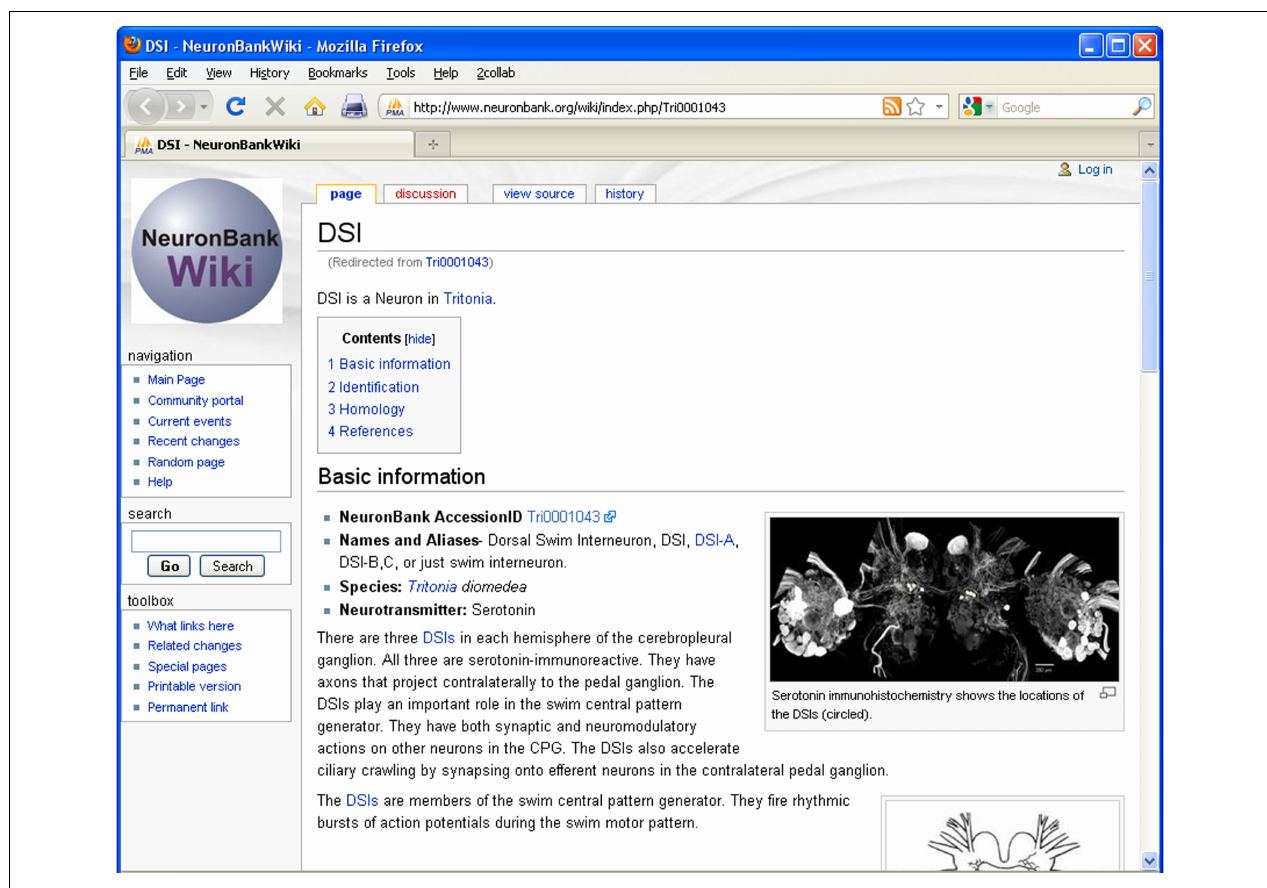
FIGURE 9 | Screen shot of the NeuronBank Wiki page for